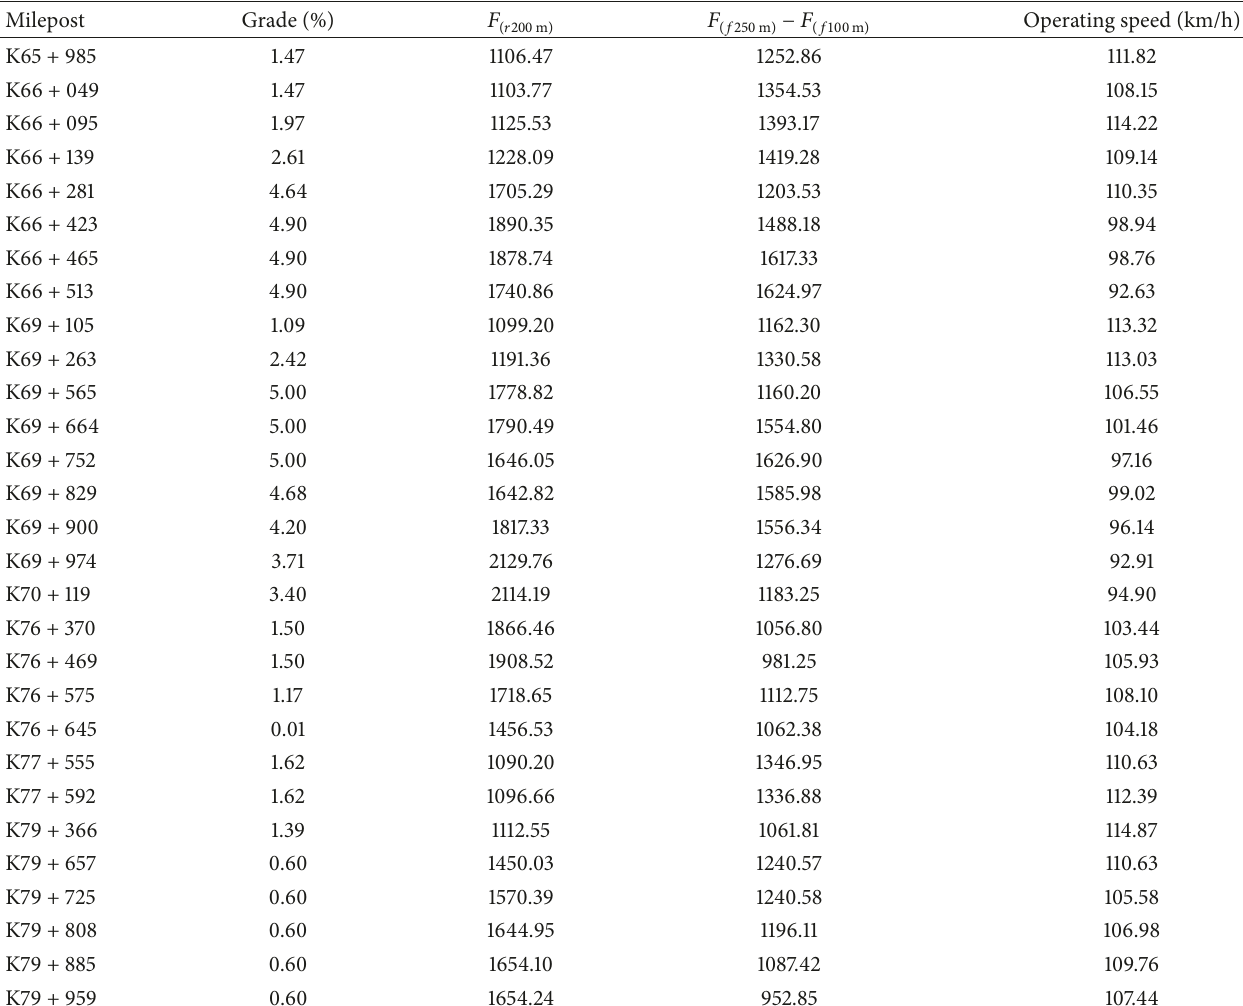
Table 2: Test data for cars.